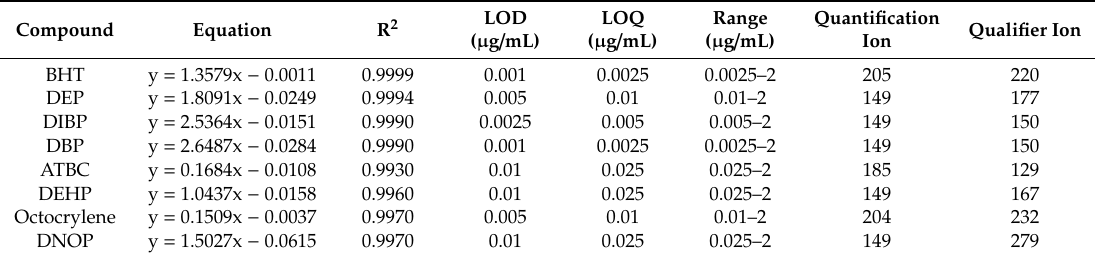
Linearity of target compounds and their, limit of detection (LOD) and limit of quantification